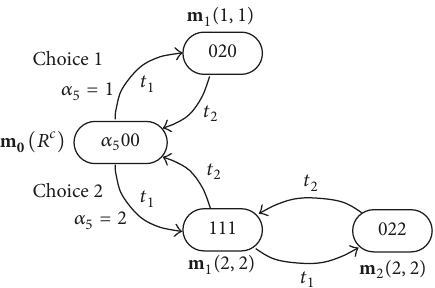
Figure 8: Steps 1 and 2 in the construction of the reachability graph of 𝑅 𝑐 . Figure 9: Reachability graph of the compound Petri net 𝑅 𝑐